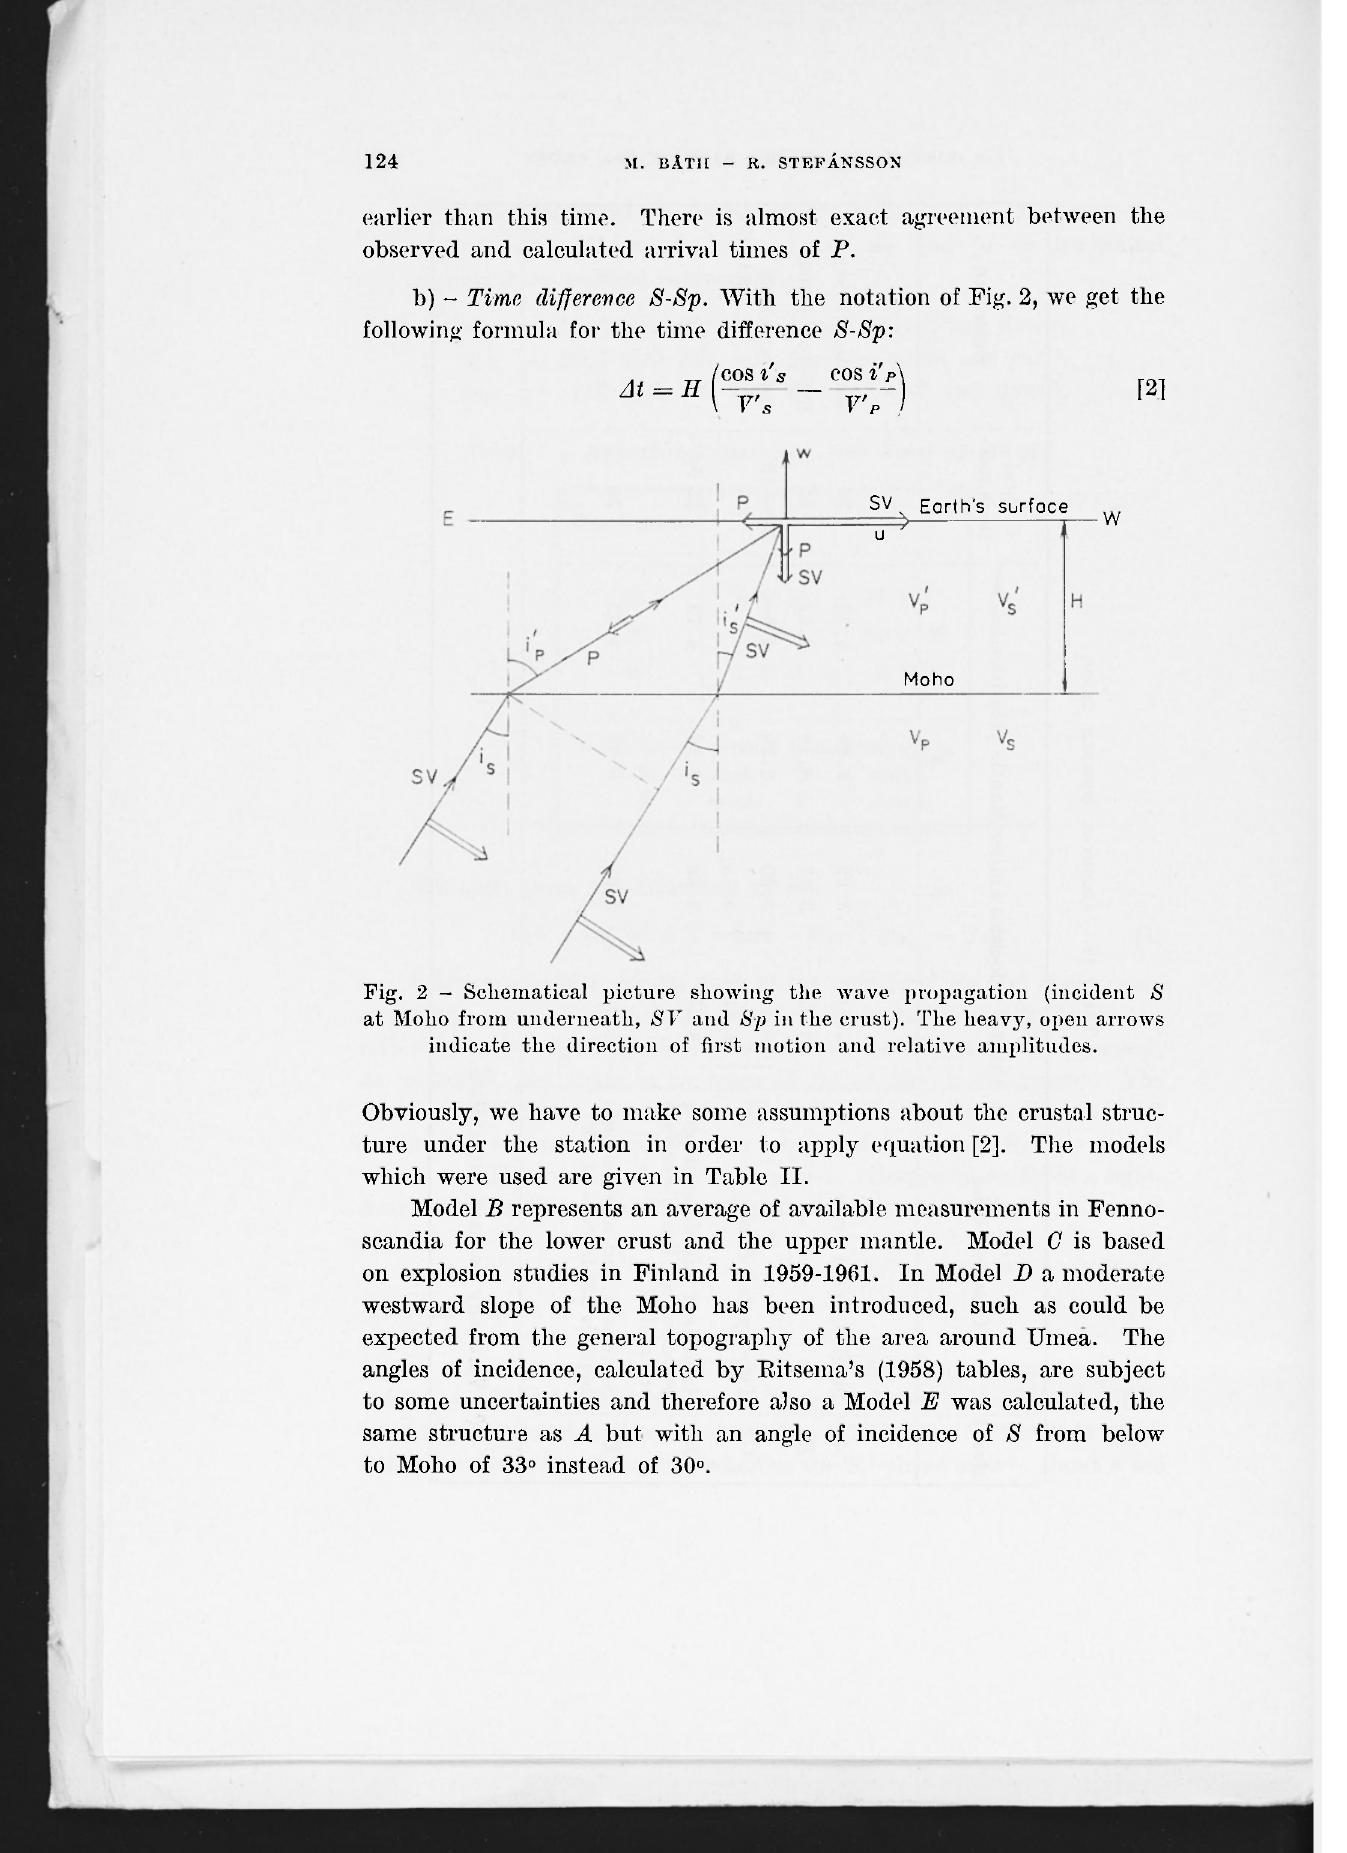
Fig. 2 - Schcmatical picture showing the wave propagation (incident S at Moho from underneath, SV and Sp in the crust). The heavy, open arrows indicate the direction of first motion and relative